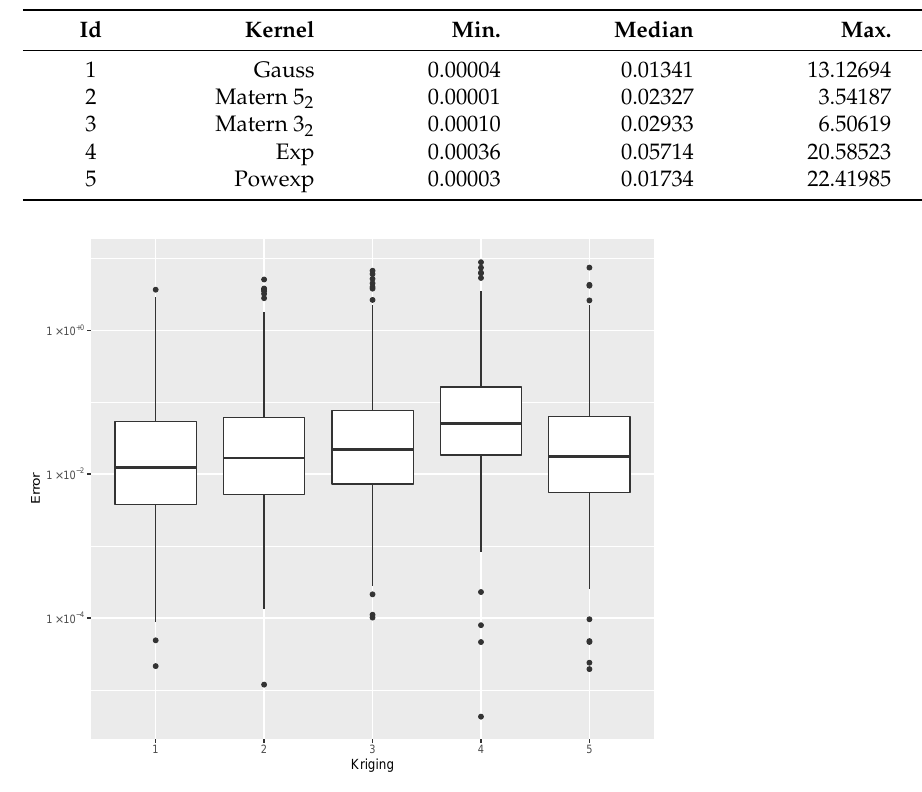
Figure 9. Error dispersion of the mass estimate using distinct Kriging kernel options. For the estimation of P critical , the errors are shown in Table 6. The error dispersion of the P critical estimate is shown in Figure 10. The Matern 3 2 kernel is the best P critical